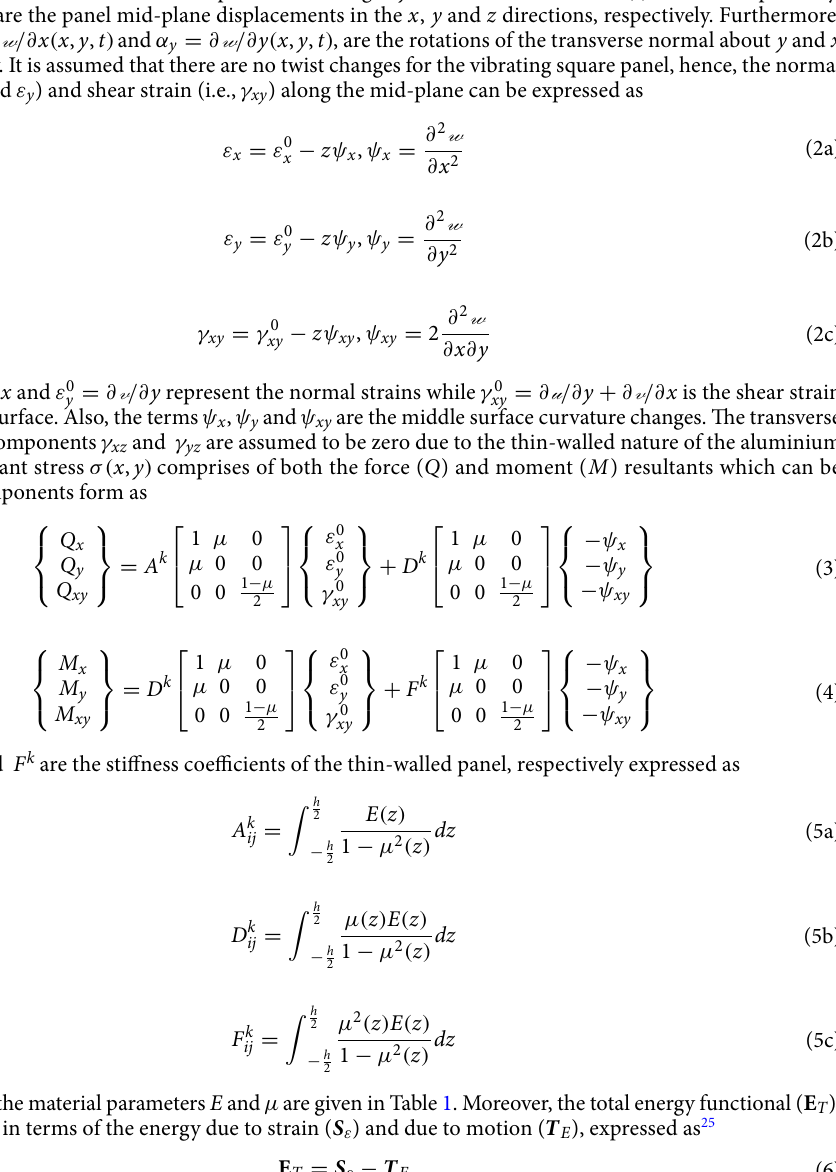
where the symbols U , V and W are the displacements along x , y and z directions at time ( t ) variable, respectively. u v w Also, , and are the panel mid-plane displacements in the x , y and z directions, respectively. Furthermore,